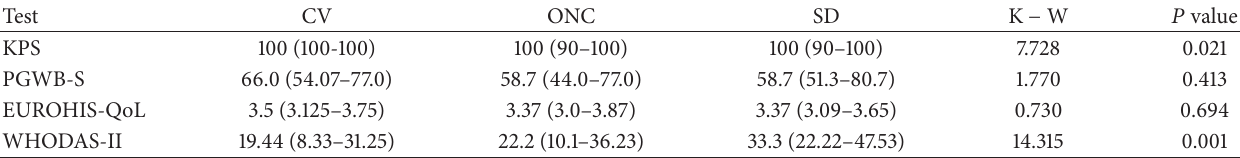
Table 5: Differences of test scores based on diagnosis, median ( 𝑄1 – 𝑄3 ).